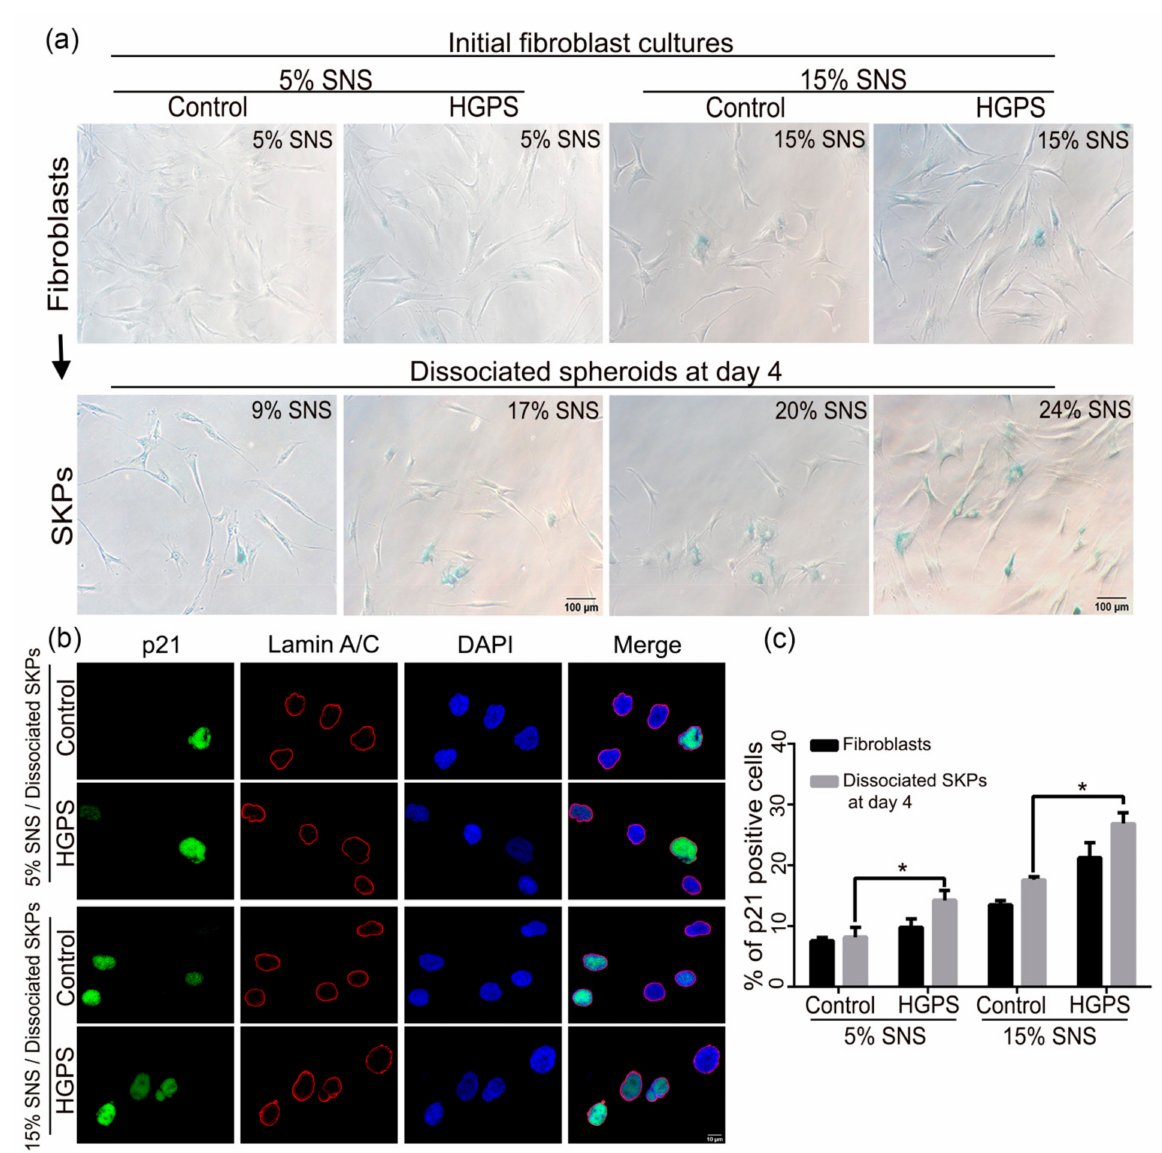
Figure 3. Senescence index of SKPs: SA- β -gal and p21 staining of original fibroblasts and dissociated SKPs at day 4. ( a ) SA- β -gal test performed using initial fibroblast cultures and on dissociated spheroids at day 4 for both control and HGPS groups starting from 5 and 15% SNS. ( b ) Immunofluorescence staining for p21 and lamin A/C in dissociated spheroids at day 4, from control and HGPS SKPs with 5 and 15% SNS. Cells were counterstained with DAPI. ( c ) Quantification of the percentage of p21-positive nuclei in the initial fibroblast cultures and in dissociated SKPs at day 4 in both control and HGPS groups. Values are presented as mean ± SD ( n = 3), * p < 0.05, ( c ) two-way ANOVA with Tukey’s multiple comparisons